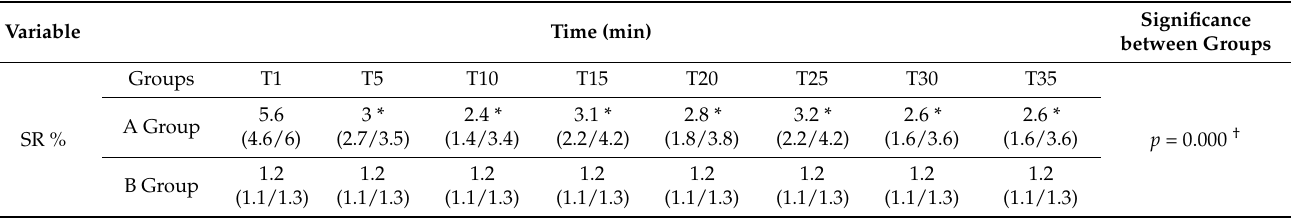
Table 1. Concentration of sevoflurane requirements (SR %).